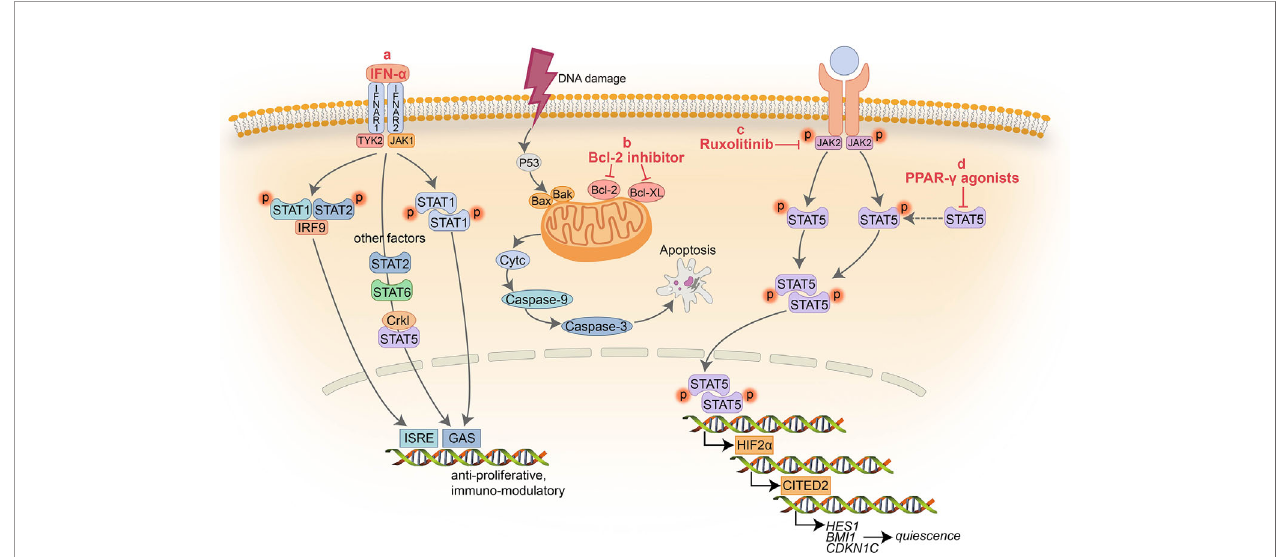
FIGURE 1 | Schematic representation of the signaling pathways targeted by non ABL-directed drugs. (A) IFN- a inhibits activation of multiple factors resulting in cell proliferation arrest and immune modulation; (B) BCL-2 inhibitors block the pro-survival activity of BCL-2 family members increasing apoptosis; (C) Ruxolitinib suppress the activity of JAK2 and downstream factors; (D) PPAR- g agonists serve as a negative transcriptional regulator of STAT5 and its downstream targets HIF2 a and